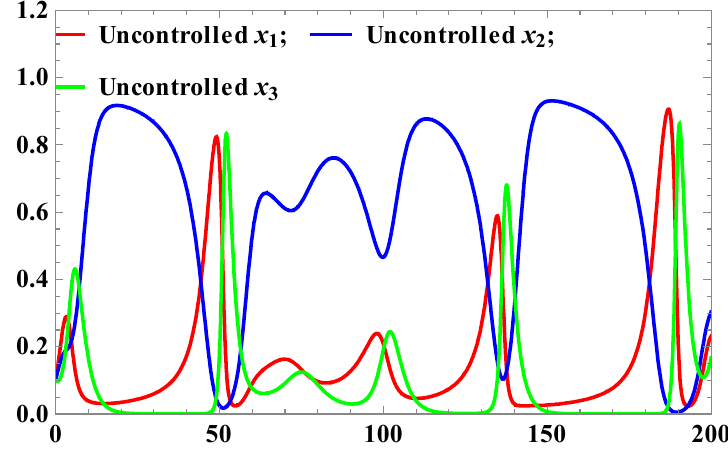
Figure 2. Time series of uncontrolled x 1 , x 2 , and x 3 .